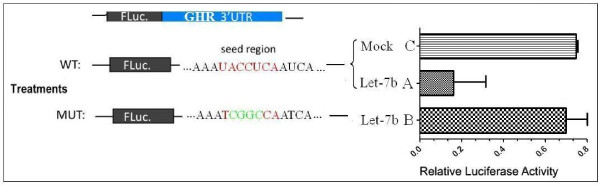
Dual-luciferase reporter assay for validation of the 3′ UTR ofGHRas the target site of the let-7bin vitrocell system. DF-1 cells were transfected with pmirGLO-let-7b-GHR 3′ UTR, pmirGLO-let-7b-GHR 3′ UTR mutation plasmid, or the control plasmid. The activity of firefly luciferase (luc2) and Renilla luciferase (hRluc-neo) was measured and relative values (luc2/hRluc-neo) calculated.